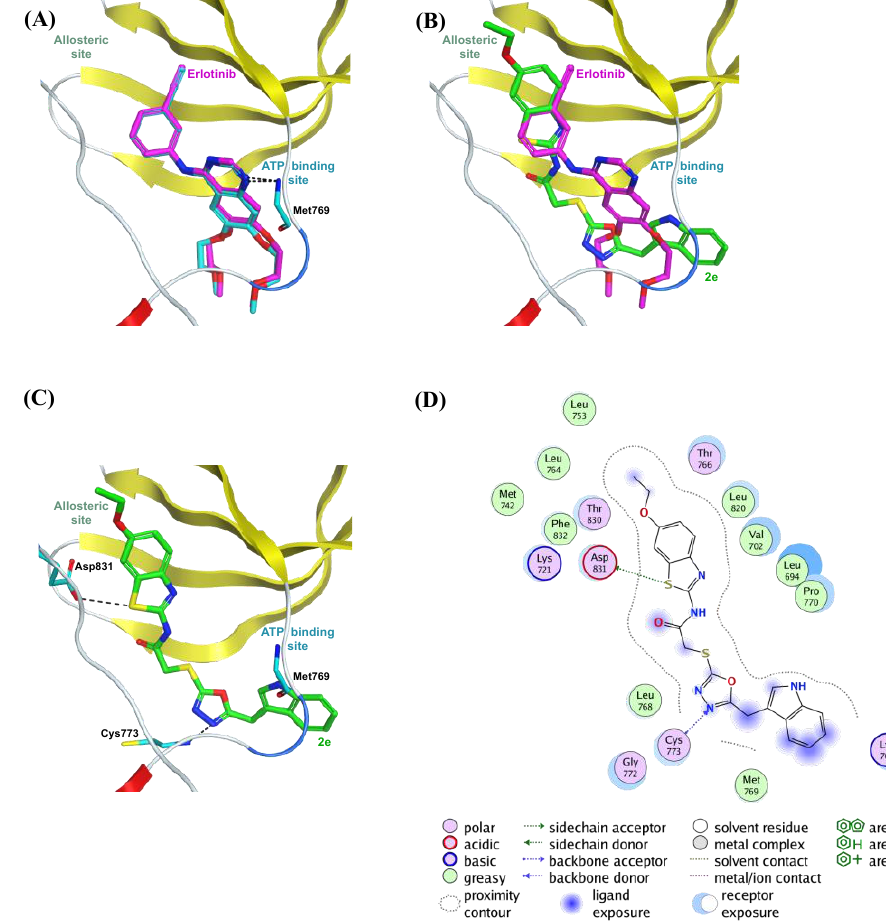
Figure 2. The top-scoring docked pose of compound 2e to the EGFR active site (PDB code 4HJO) as predicted by MOE 2019.01. ( A ) Comparison of modeled binding mode of the co-crystallized ligand erlotinib (magenta sticks) and its superimposed docking conformation (cyan sticks). ( B ) Comparison of modeled binding mode of compound 2e (green sticks) and erlotinib (magenta sticks). ( C ) Detailed binding mode of compound 2e (green sticks) displaying hydrogen bonds (black dashed line) with the critical amino acid residues (cyan sticks). ( D ) Two-dimensional depiction of compound 2e binding interactions with the essential amino acid residues.